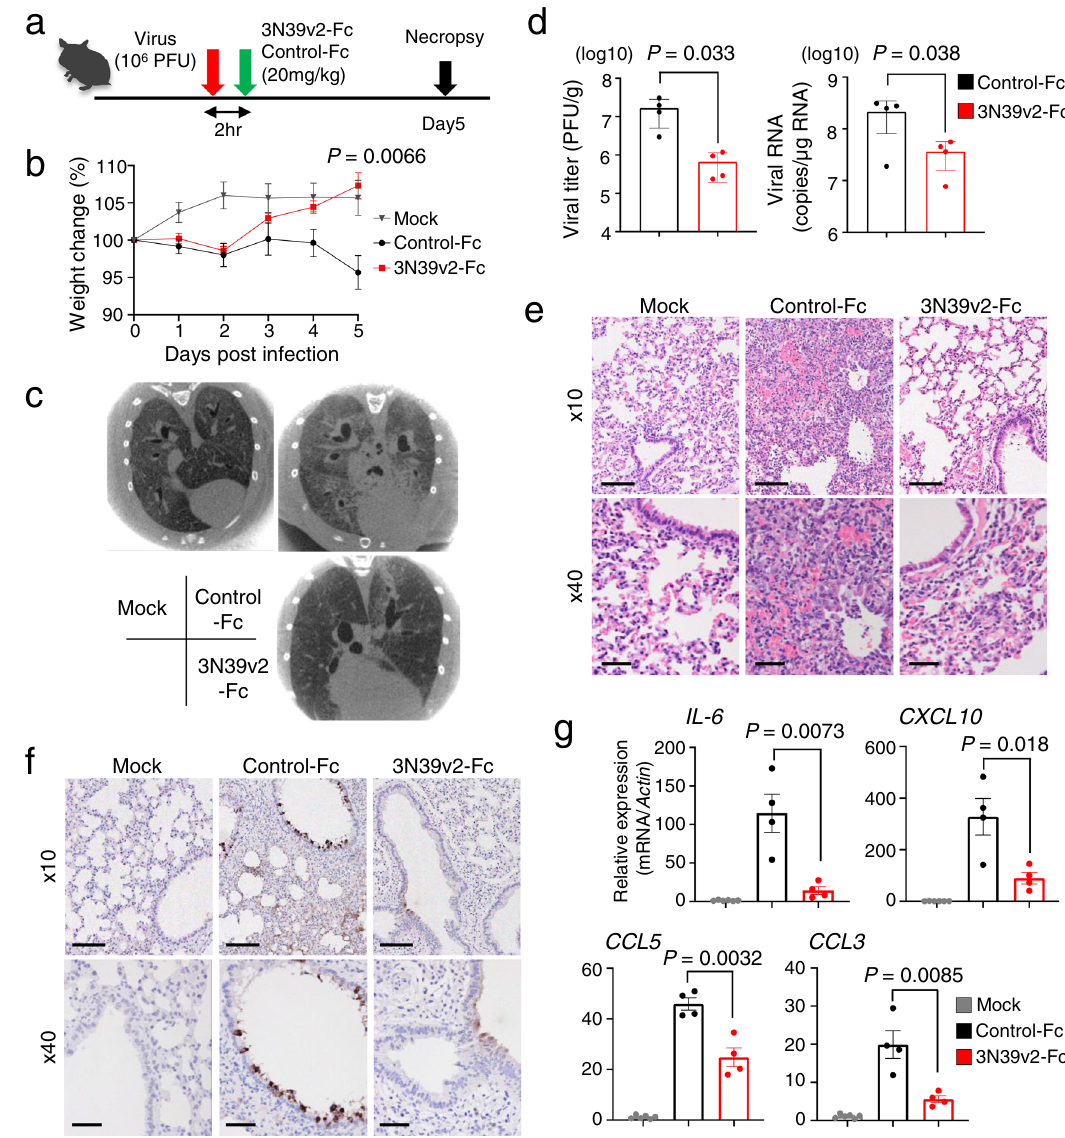
Fig. 5 Therapeutic ef fi ciency of 3N39v2-Fc in a COVID-19 Hamster Model. a Schematic overview of the animal experiment. b Percent body weight change was calculated from day 0 for all hamsters. c Axial CT images of the thorax 5 days after infection. d Quanti fi cation of plaque-forming units (PFU) from lung homogenates and genomic SARS-CoV-2 RNA as copies per μ g of cellular transcripts. e H&E staining and f SARS-CoV-2 antigen staining of hamster lung lobes. Scale bars, 100 μ m (upper panel) and 40 μ m (lower panel). g mRNA expression of in fl ammatory or chemotactic cytokines in hamster lung lobes. b , d , g Data are mean ± SEM of n = 6 for mock group, 4 for each treated group. P -values by two-sided unpaired t-